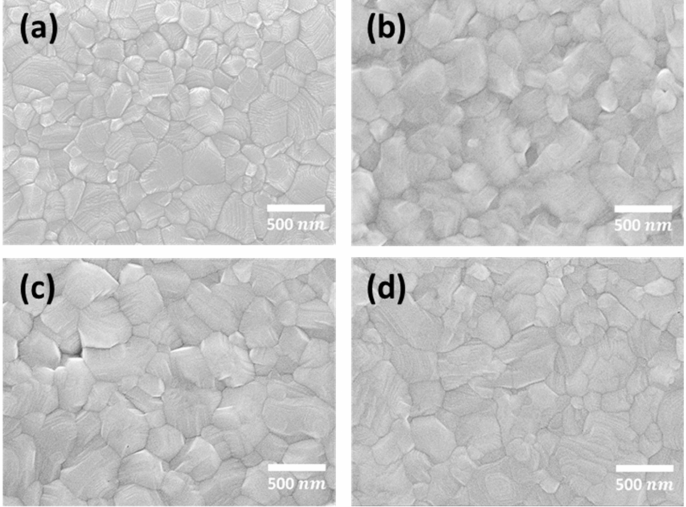
Figure 4. SEM top view of ( a ) perovskite film without KI (thermal baking time: 10 min); and perovskite films with 0.03 M KI under various thermal baking times: ( b ) 10 min, ( c ) 30 min, and ( d ) 50